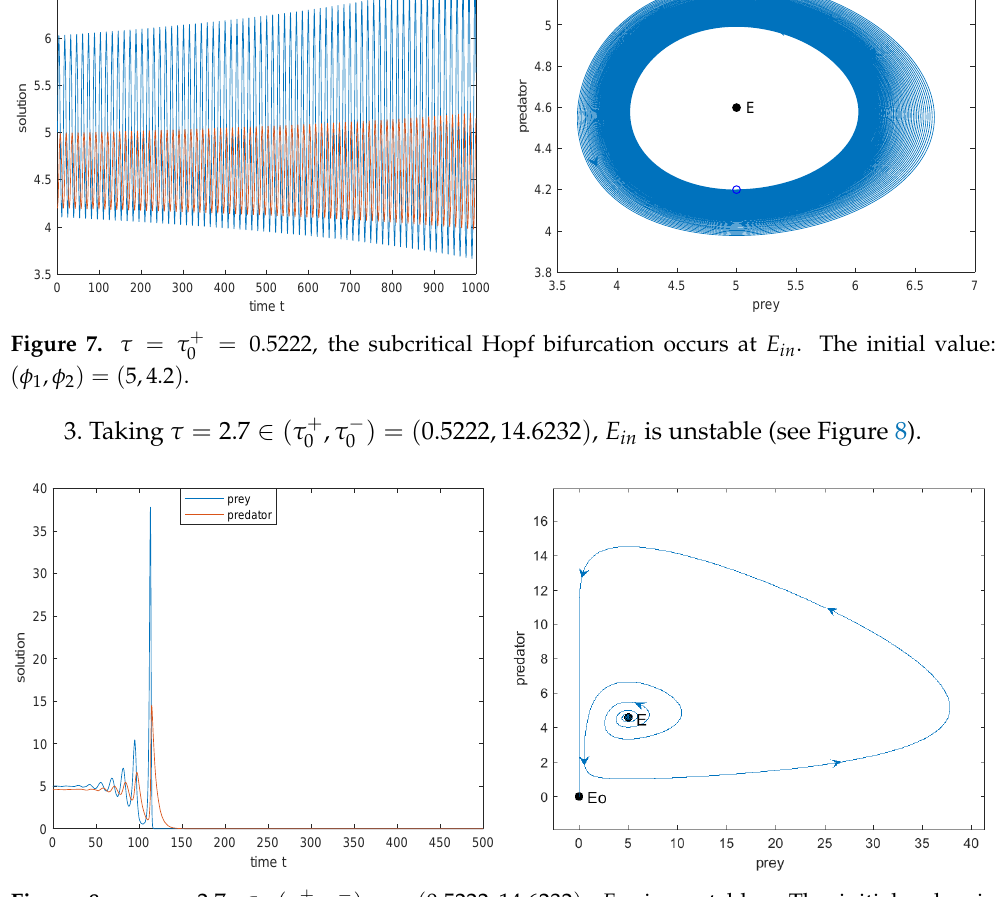
Figure 8. τ = 2.7 ∈ ( τ + ( φ ) = ( 5,4.59 ) 1 , φ 2